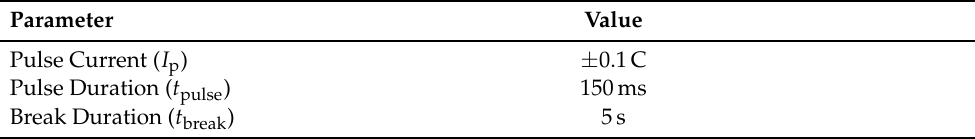
Table 3. Parameters for the pulses depicted in Figure 1b used for the R C-rate for the pulse current is related to the nominal capacity ( C nom ) from Table